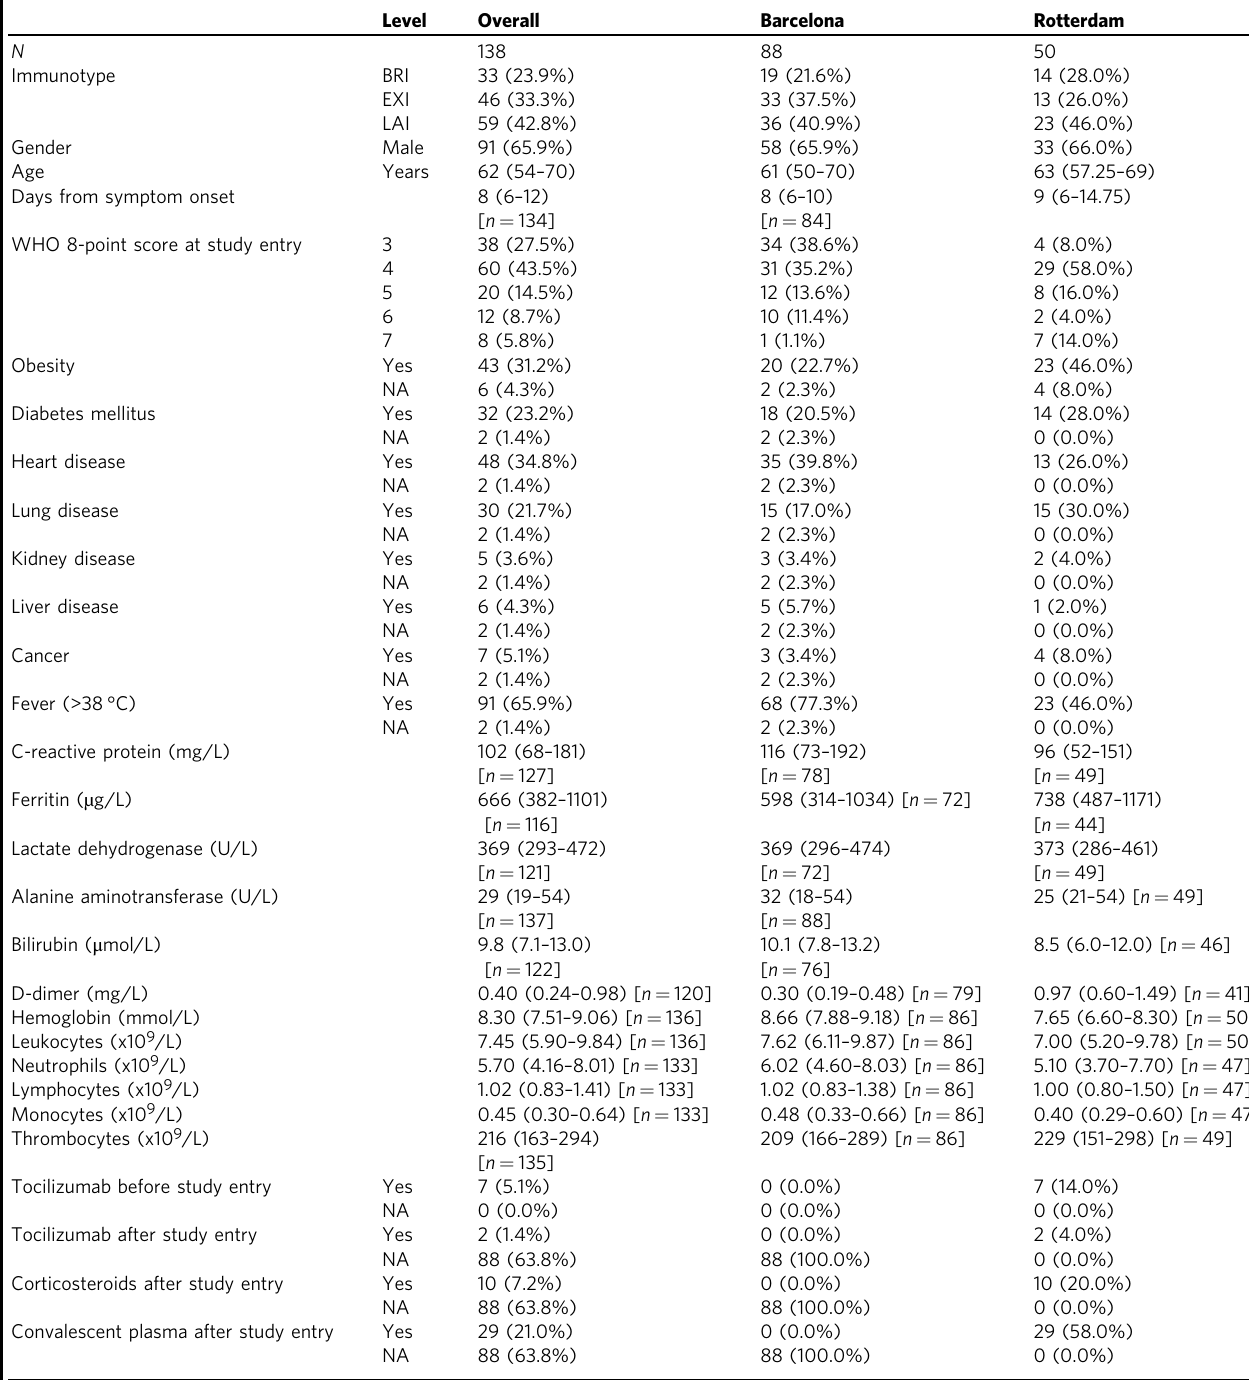
Table 1 Clinical and laboratory characteristics of Rotterdam discovery and Barcelona validation